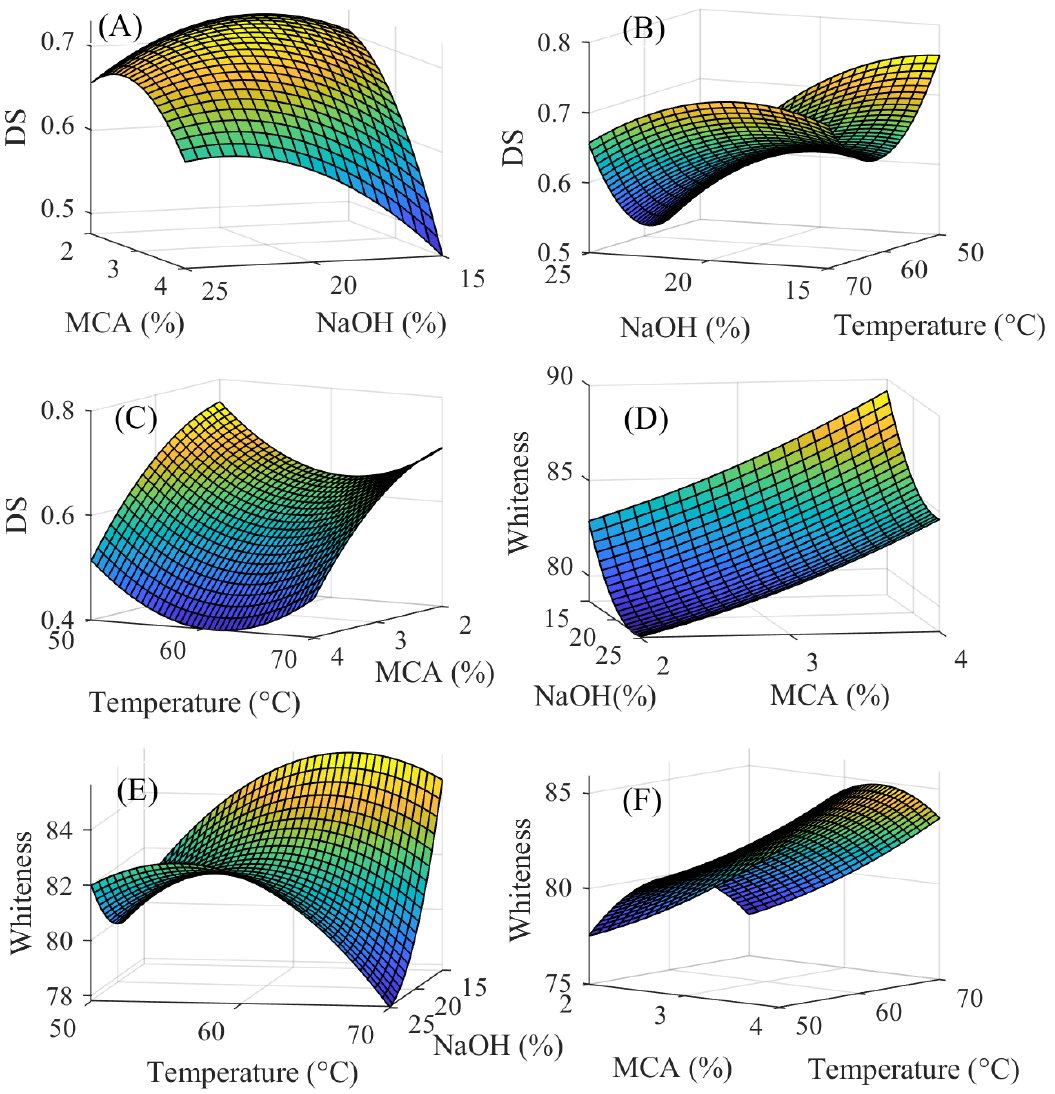
Figure 3. Three dimensional surface plots of quadratic regression models for ( A – C ) degree of substitution (DS) and ( D – F ) whiteness of CMC synthesized from purified cellulose when NaOH concentration (15 – 25 wt%), MCA concentration (2 – 4 wt%) and etherification temperature (50 – 70 °C) were varied.